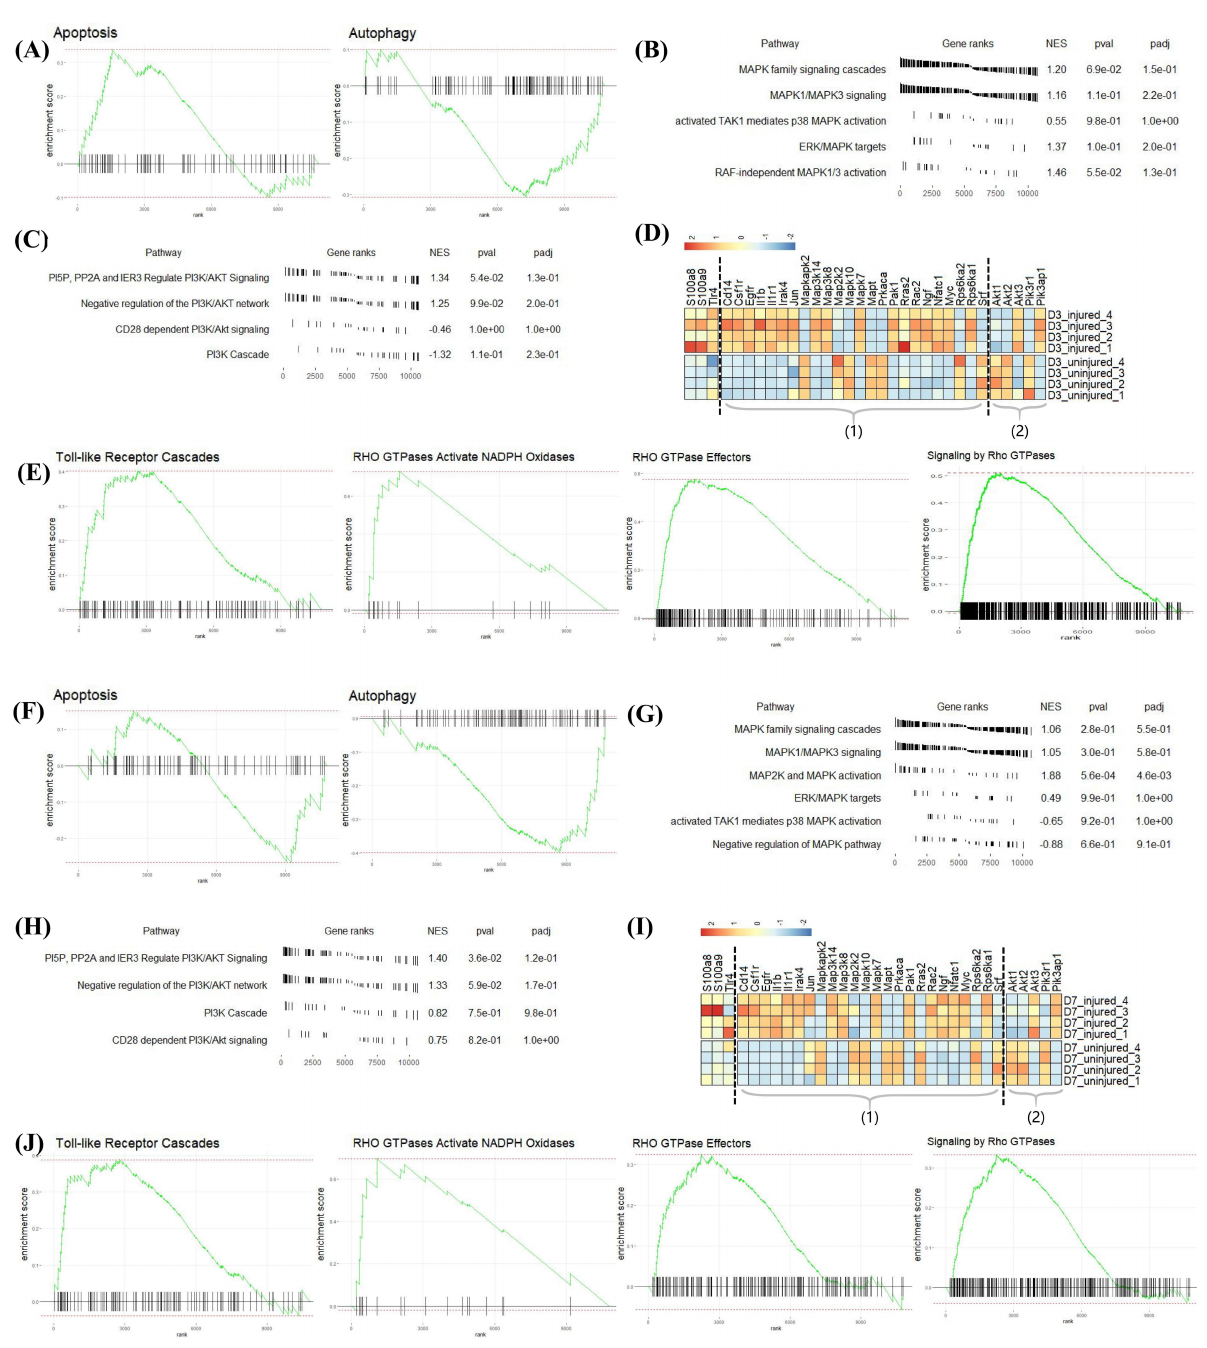
Figure 7. GSEA analysis of all DEGs at each point post-MI in mRNA-seq data. ( A ) Apoptosis and autophagy enriched in DEGs on day 3 post-MI, ( F ) day 7 post-MI. ( B , C ), respectively, rep- resent the expression of related items in the MAPK signaling pathway and PI3K-AKT signaling pathway on day 3 post-MI; ( G , H ) are on day 7 post-MI. ( D , I ) Heatmaps revealing the expression of key genes in the injured and uninjured areas at various time points after MI. Part (1) includes MAPK-signaling-pathway-related genes; (2) contains PI3K-AKT-signaling-pathway-related genes. ( E , J ) 4 GSEA pathways annotated by S100a8/a9 on day 3 post-MI. NES: Normalized Enrichment Score, which normalizes the enrichment score according to the size of the gene